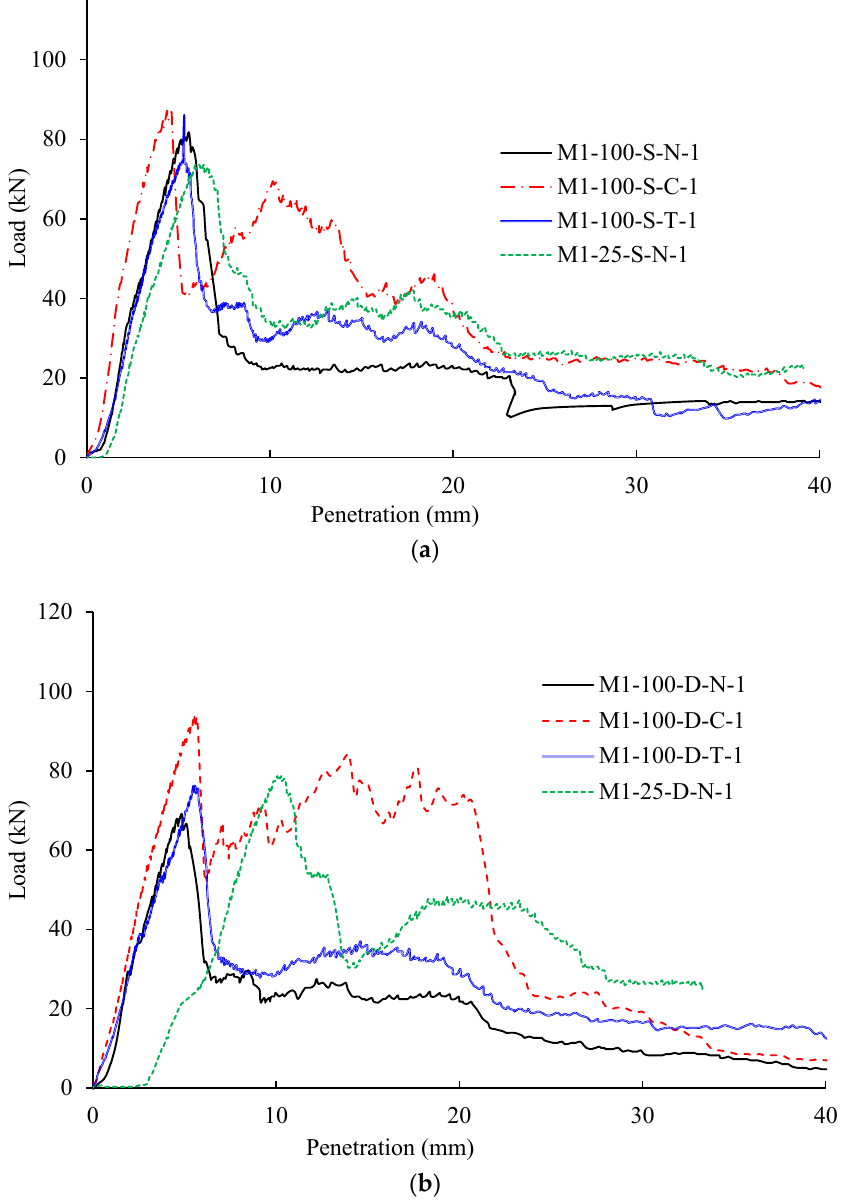
Figure 5. Load vs. projectile penetration plots for concrete slabs of mix M1: ( a ) singly reinforced; ( b ) doubly reinforced.